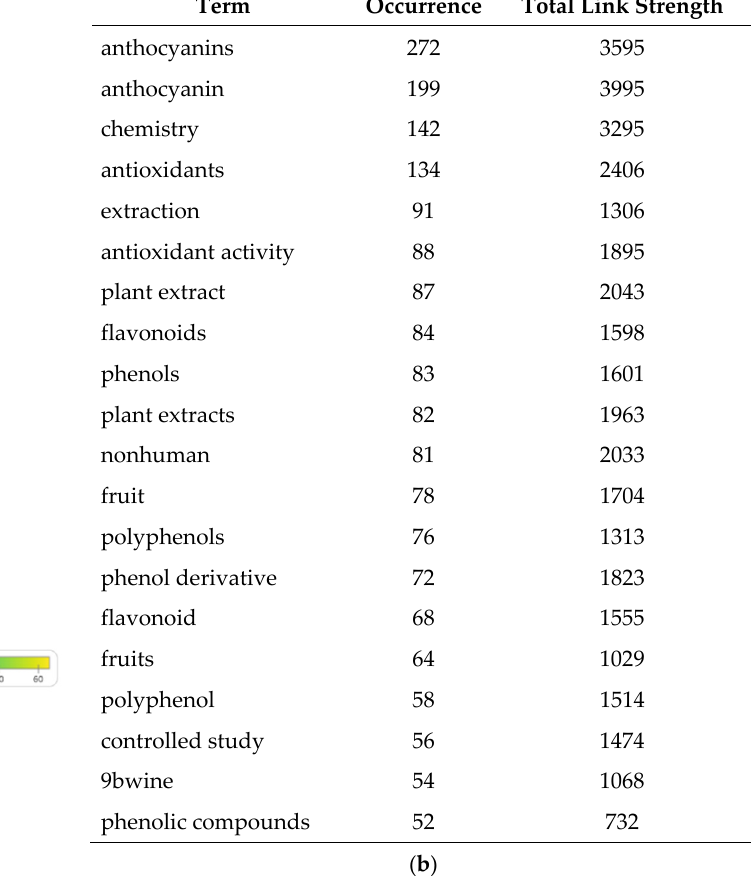
Figure 3. ( a ) Bubble map visualizing words from titles, abstracts, and keywords of anthocyanin, sustainable source, and waste relationship publications. Bubble size indicates the number of publications. Bubble color represents the citations per publication (CPP). Two bubbles are closer to each other if the terms co-appeared more frequently (based on data from Scopus and elaborated by VOSviewer software). ( b ) The top 20 recurring terms (based on data from Scopus and elaborated by VOSviewer software).